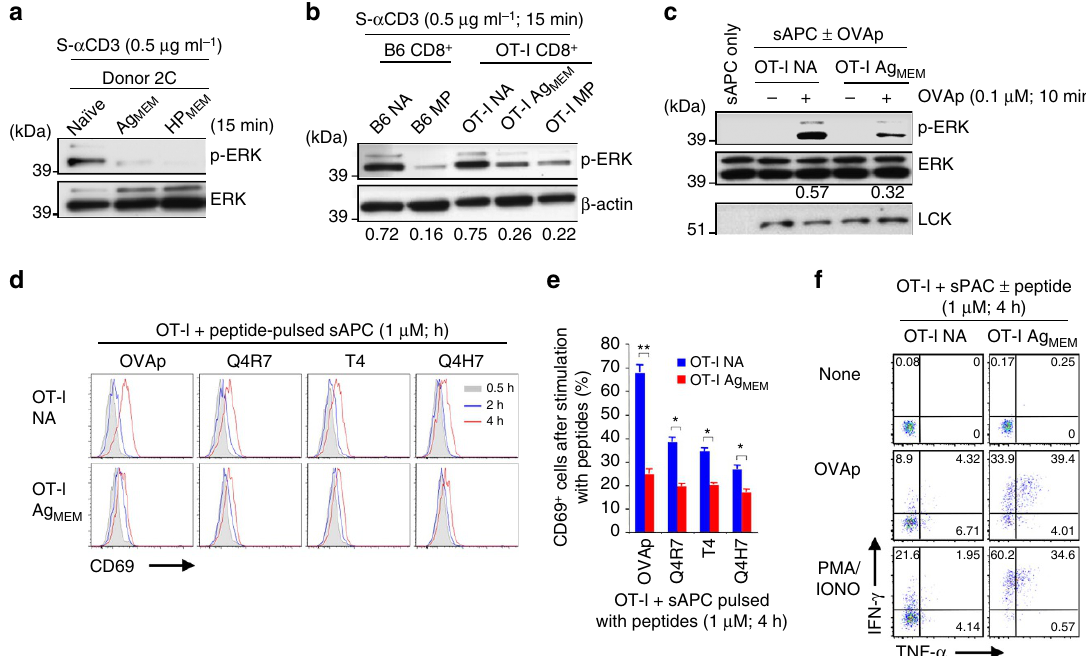
Figure 3 | TCR desensitisation in induced memory CD8 þ T cells. ( a ) Naı¨ve 2C CD8 þ T cells were transferred into irradiated B6 mice and then immunized with specific peptide (Ag MEM ; n ¼ 5) or left unimmunized to form memory cells via lymphopenia-induced proliferation (HP MEM ; n ¼ 4). The memory 2C cells purified at 56 d and freshly isolated naı¨ve 2C cells ( n ¼ 3) as controls were analysed for ERK phosphorylation after incubation with S- a CD3 mAb. ( b ) Memory OT-I CD8 þ T cells obtained by adoptive transfer into B6 hosts and immunization with OVAp-pulsed BMDC (OT-I Ag MEM ; n ¼ 5), together with host-derived B6 naı¨ve (NA) CD44 lo and CD44 hi (MP) CD8 þ T cells, were analysed for ERK phosphorylation after incubation with S- a CD3 mAb. Naı¨ve and MP OT-I cells from unimmunized OT-I Tg mice ( n ¼ 3) were used as control. ( c ) OT-I naı¨ve and Ag MEM obtained as in b were incubated with either unpulsed or OVAp-pulsed splenic APC (sAPC) and analysed for ERK phosphorylation; note that LCK is not detectable with sAPC only. ( d , e ) Flow cytometry for CD69 upregulation ( d ) and percentages of CD69 þ cells ( e ; mean ± s.d.) on OT-I naı¨ve and memory cells as in c after incubation with sAPC pulsed with OVAp and its variant peptides, Q4R7, T4 and Q4H7. ( f ) IFN- g and TNF- a production from OT-I naı¨ve and memory cells as in c after incubation with sAPC ± OVAp or PMA plus ionomycin (PMA/IONO). Data are representative of two ( f ) and three ( a - e ) independent experiments. Unpaired Student’s t -test was used for the statistical analysis. * P o 0.005; ** P o 0.0005. NATURE COMMUNICATIONS|7:13373|DOI: